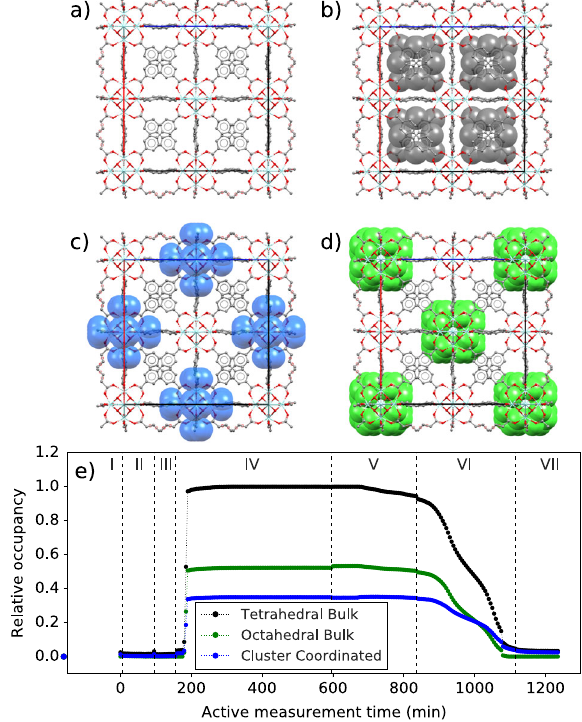
Fig. 3 Pore site occupancies. The UiO-67 framework is shown a empty, b with fi lling sites in the tetrahedral pores, c with sites directly coordinating the Zr 6 O 8 clusters, and d with fi lling sites in the octahedral pores. e Occupancies obtained from sequential Rietveld re fi nement are shown, relative to the maximum value of the tetrahedral